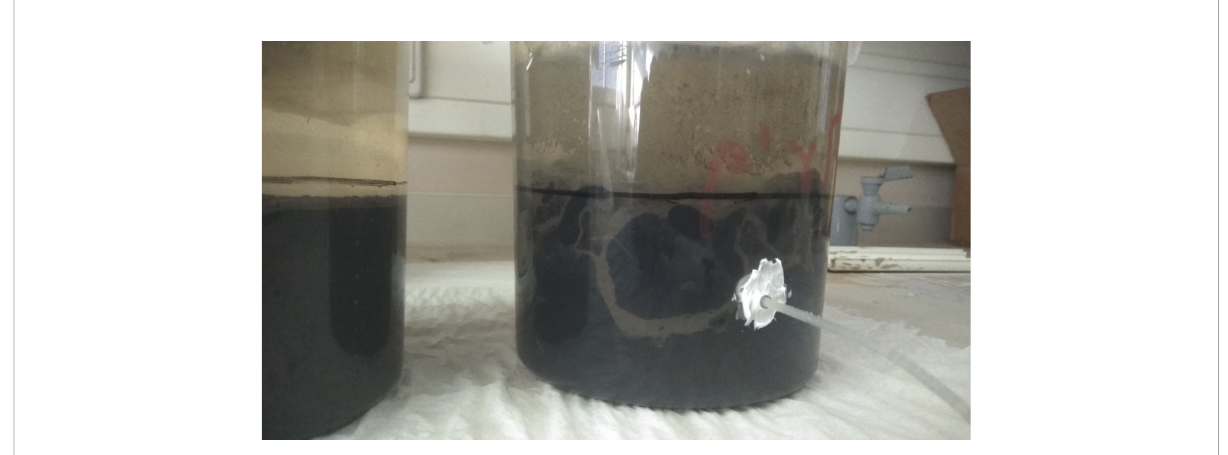
FIGURE 1 Photograph of experimental setup showing sul fi dic sediment with oxidized worm burrows. Rhizon sampler for taking sediment pore water samples also